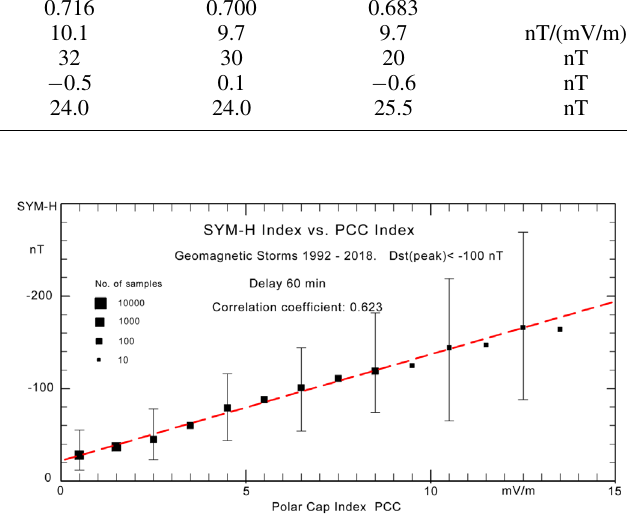
Table 2. Number of samples, correlation coef fi cients, and regression results for ASY-H/PC relations. Parameter PCC PCN PCS PCA Samples